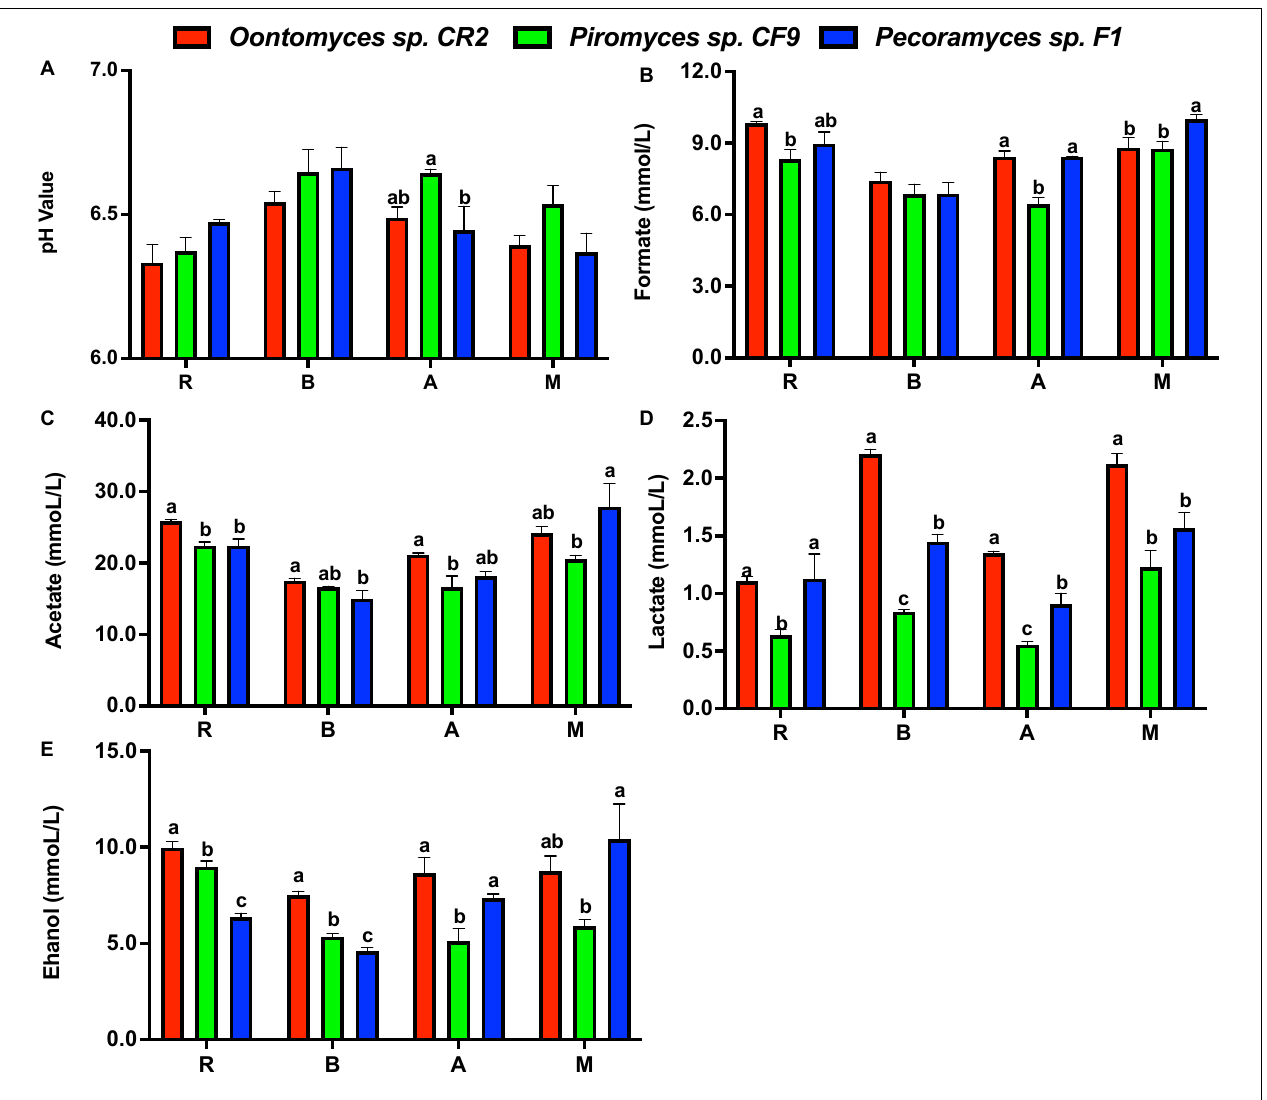
FIGURE 5 | The pH value (A) and concentrations of formate (B) , acetate (C) , lactate (D) , and ethanol (E) in the supernatant of different fermentations (R, Reed; B, Broussonetia papyrifera leaves; A, Alfalfa stalk; M, Melilotus officinalis ). The error bars represent the standard error of the mean ( n = 4), and means with different letters in the same column are different at P <